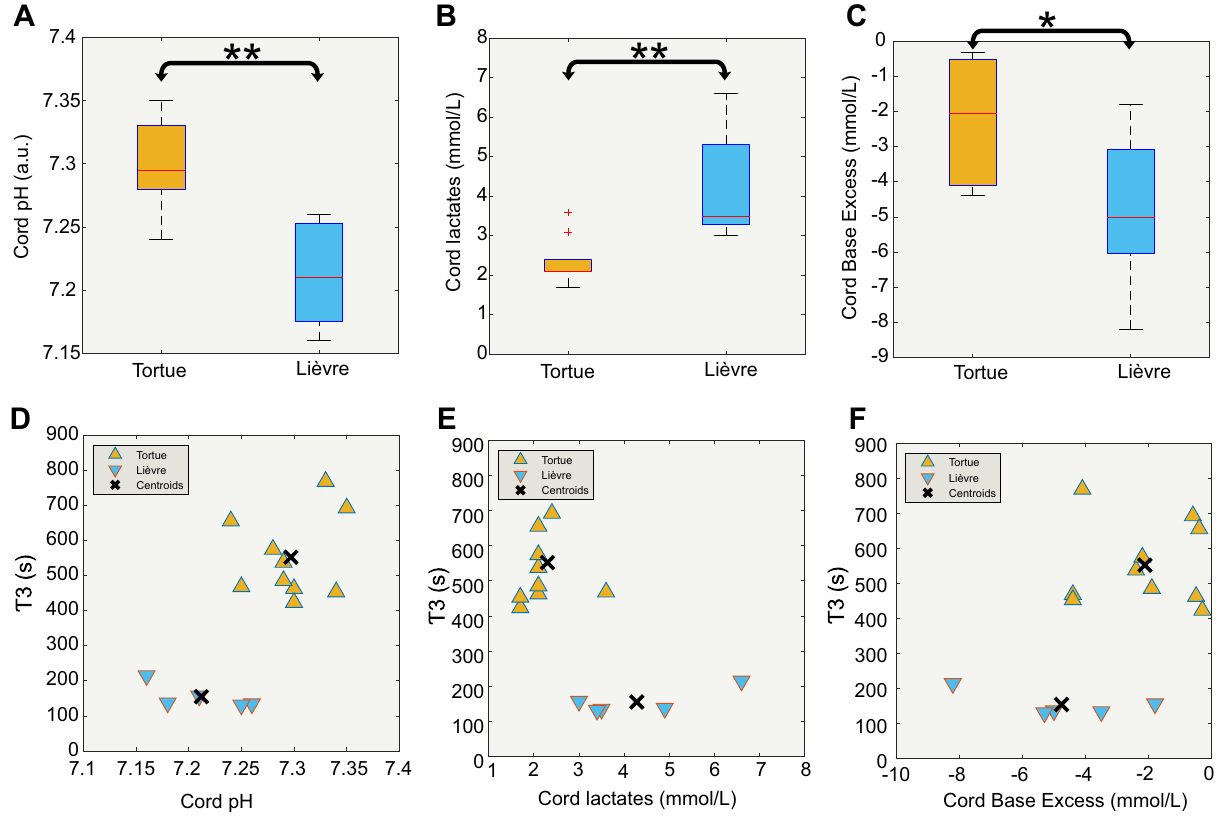
Figure 5. ( A to C ) Boxplots presenting the statistical differences between the two clusters, “Lièvre” (n = 5) and “Tortue” (n = 10) in cord gas, cord pH, cord lactates, and cord base excess. ( D to F ) Two-dimensional clustering results are presented based on τ3 and cord pH ( D ), τ3 and cord lactates ( E ), and τ3 and cord base excess ( F